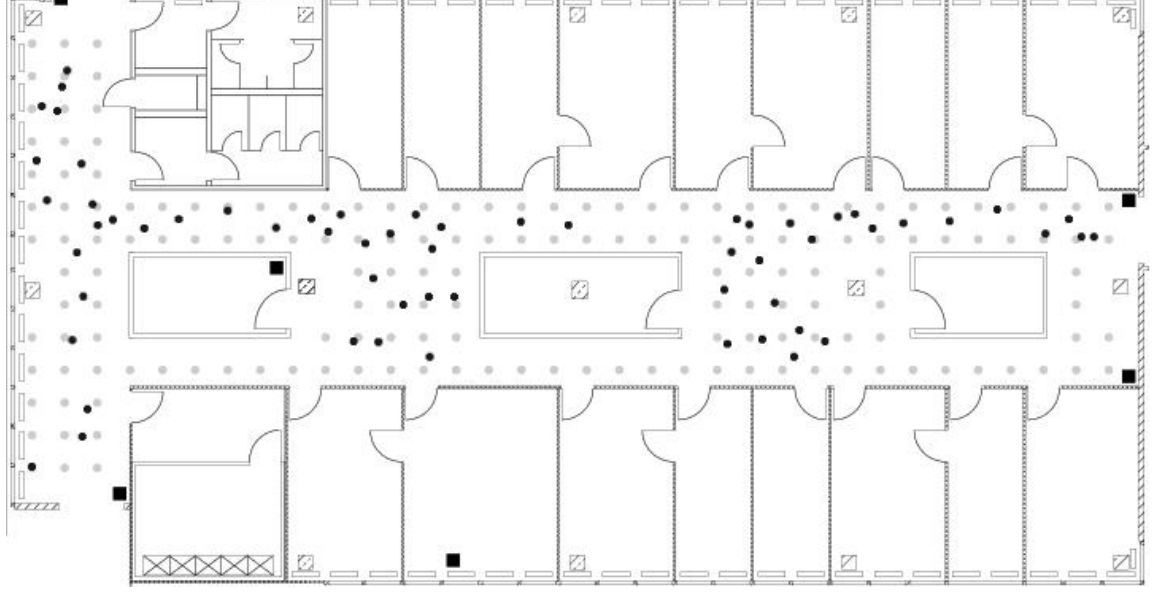
Figure 3. Layout of the testbed floor at University of Mannheim. The gray dots represent the offline reference locations; the black dots represent the selected online locations; and the squares show the location of access